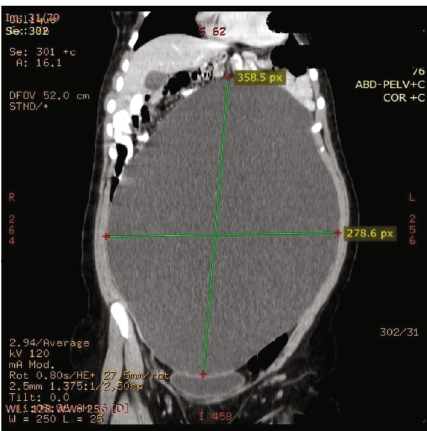
Figure 1: CT scan demonstrating the largest dimensions of the cyst ( 36 × 28 cm) prior to excision.